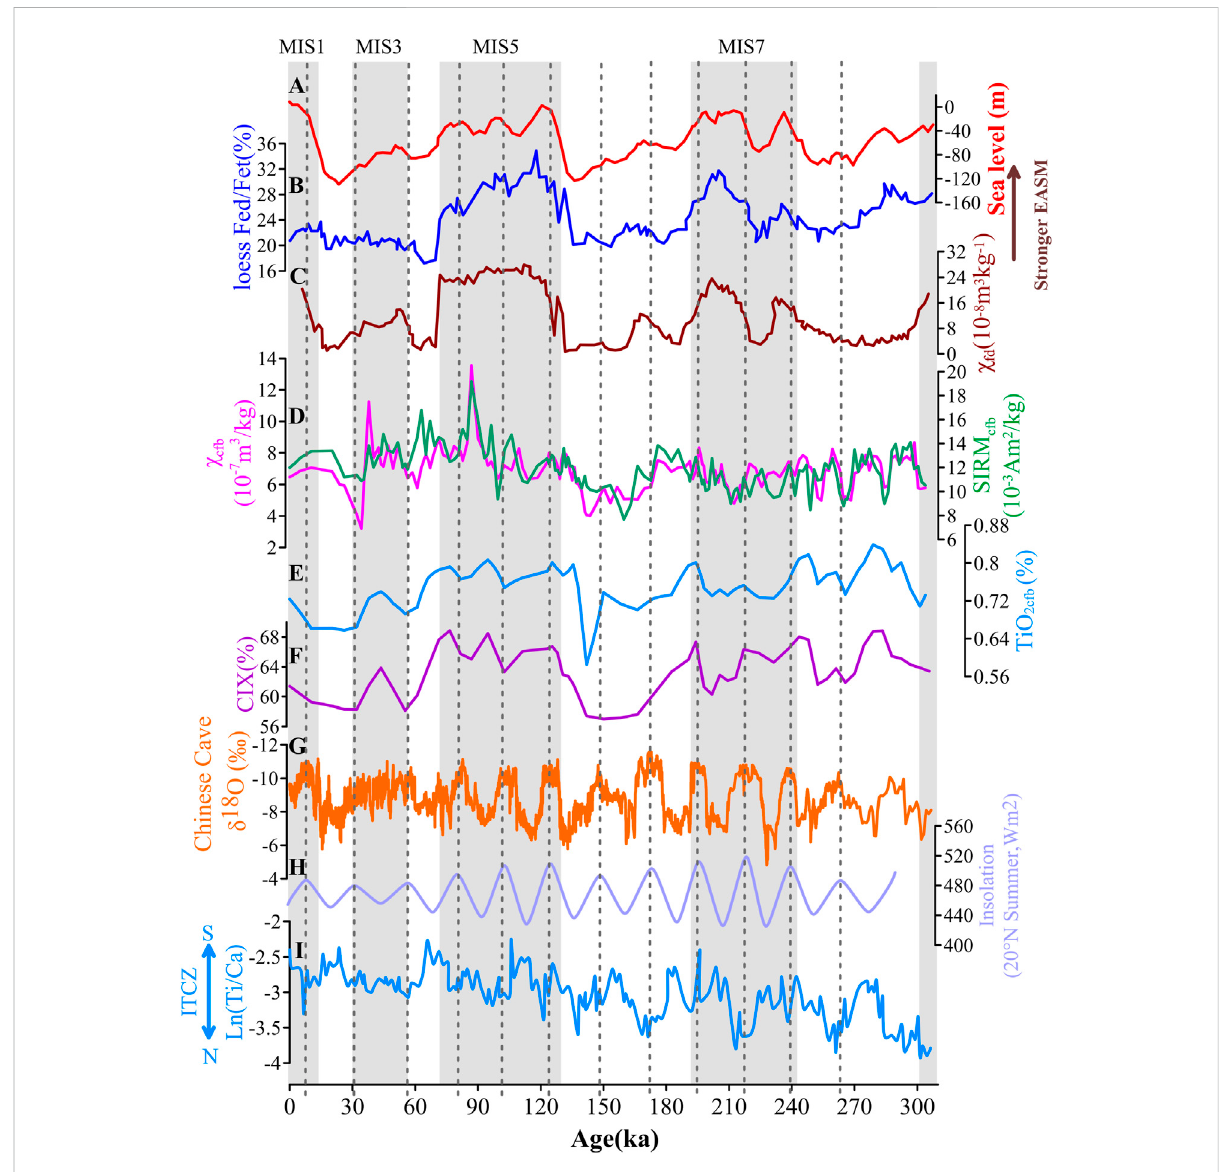
FIGURE 10 The variation of precipitation index of the H10 core over the past 300 ka. (A) Sea level (Spratt and Lisiecki, 2014); (B) Chemical weathering indicator F ed /F et of the Xifeng loess (Guo et al., 2000); (C) magnetic susceptibility frequency ( χ fd ) records of the Luochuan loess (Hao et al., 2012); (D) carbonate-free basis χ ( χ cfb , magenta), carbonate-free basis SIRM (SIRM cfb , gray); (E) carbonate-free basis TiO 2 (TiO 2cfb ) of the H10 sediment; (F) CIA valueoftheH10coresediment; (G) δ 18 OsequenceofstalagmitesintheChina ’ sSanbaoCave(Wangetal.,2008); (H) summersolarinsolationat 20 ° N (Laskar et al., 2004); (I) the ln (Ti/Ca) indicator of ITCZ swing from the MD05-2920 core. Gray bars represent the interglacial periods, and gray broken lines indicate the maximum solar insolation